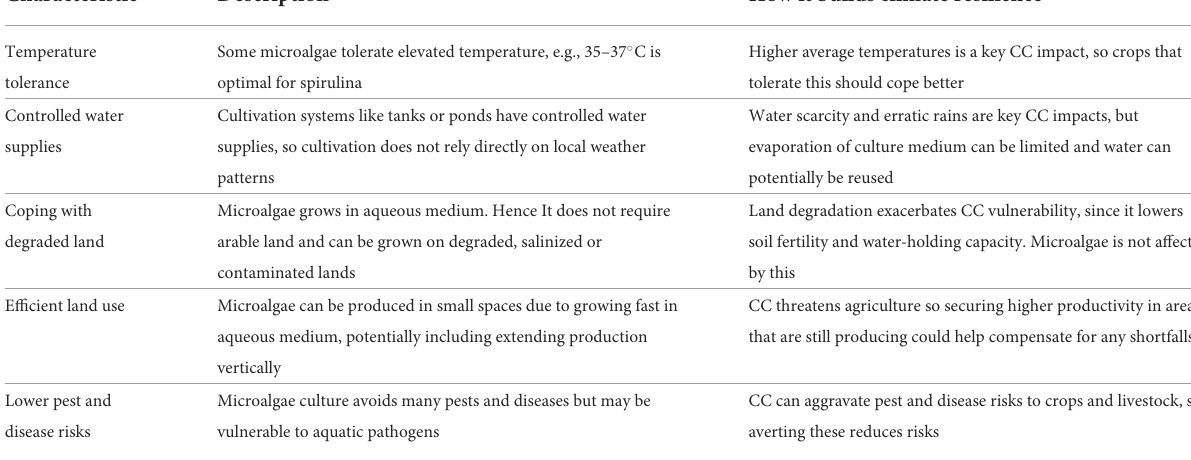
TABLE 3 Key characteristics of microalgae flagged in the papers reviewed and their linkages to climate